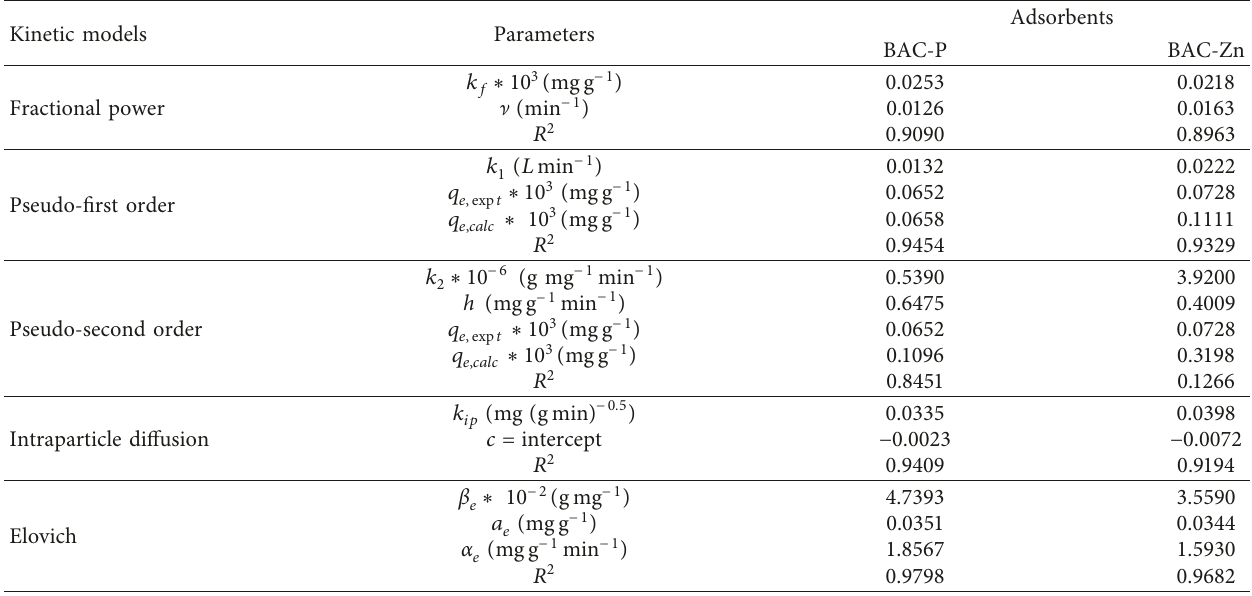
Table 5: Kinetic model constants and coefficient of correlation values of different kinetic models for Cu(II) ions.